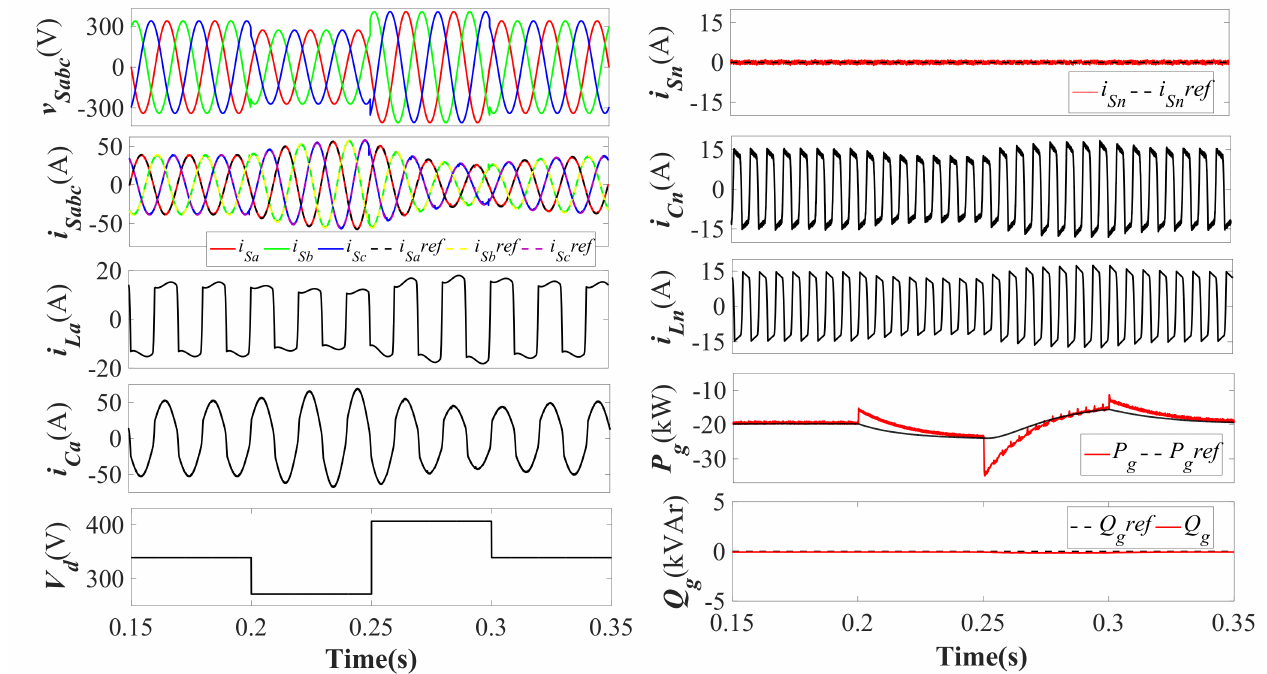
Figure 12. Dynamic performance during abnormal grid mode of v sabc , i sabc , i Ca , V d , i La , i Sn , i Cn , i Ln , P g , and Q g .